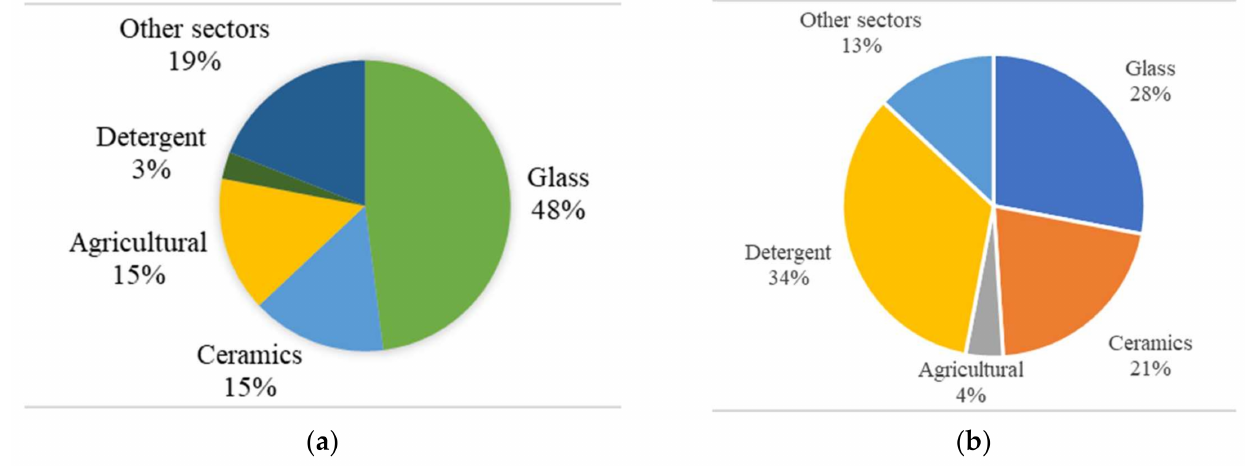
Figure 2. ( a ) Usage of boron in the world and ( b ) usage of boron in Turkey. When sectoral usage is examined in Turkey, it is seen that boron is used 28% in the glass sector, 21% in the ceramics sector, 4% in the agricultural sector, 34% in the detergent sector, and 13% in other sectors (Figure 2b). Detergent constitutes the highest rate of domestic use. It is used by converting it into etimatic, which is a tincal–boron detergent product extracted at the Eskisehir–Kirka plant